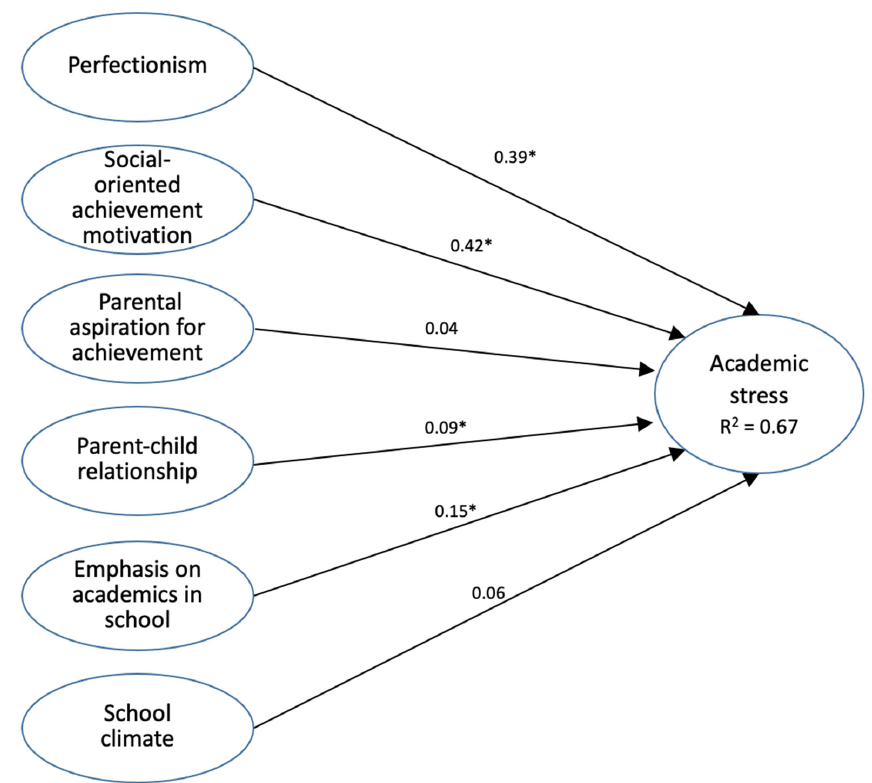
Figure 1. Structural equation modelling of effects on academic stress by perfectionism, social-oriented achievement motivation, parental aspiration for achievement, parent–child relationship, emphasis on academics in school, and school climate (numbers are the standardized effects. Those with * are significant at p < 0.01).